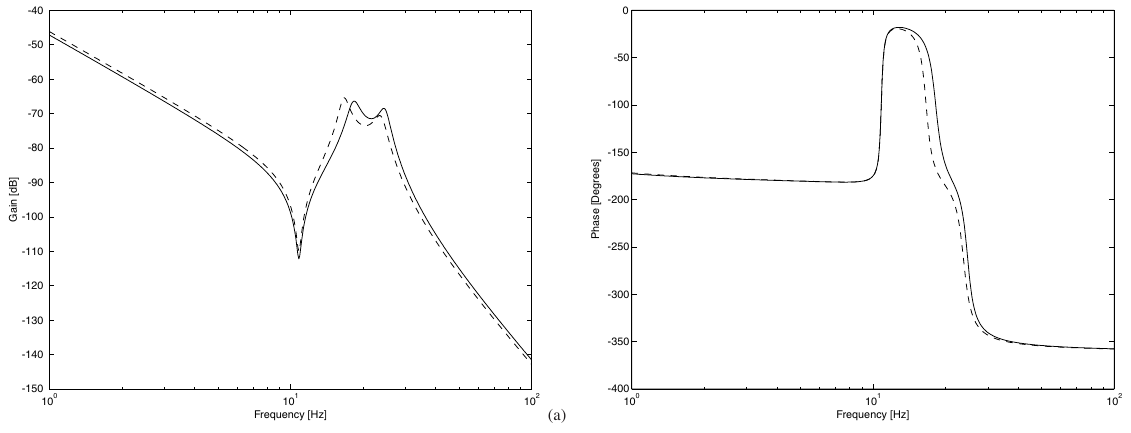
Fig. 2. Plot of the open-loop frequency responses, between the servo-amplifier input and breech angle for the gain (a) and phase (b), with the OOB [solid] and balanced [dash] gun.